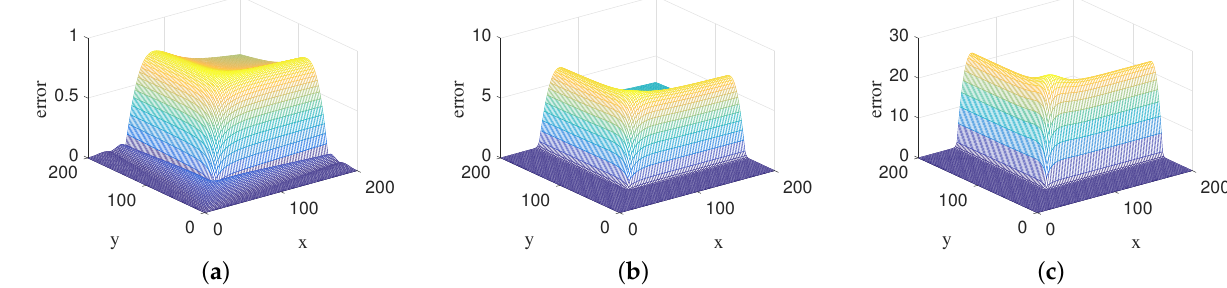
Figure 12. ( a ) denotes | kv − v | for different x , y when H x = H y = H z = 0.3 and z = 100, ( b ) denotes | kv − v | for different x , y when H x = H y = H z = 0.5 and z = 100 and ( c ) denotes | kv − v | for different x , y when H x = H y = H z = 0.7 and z =